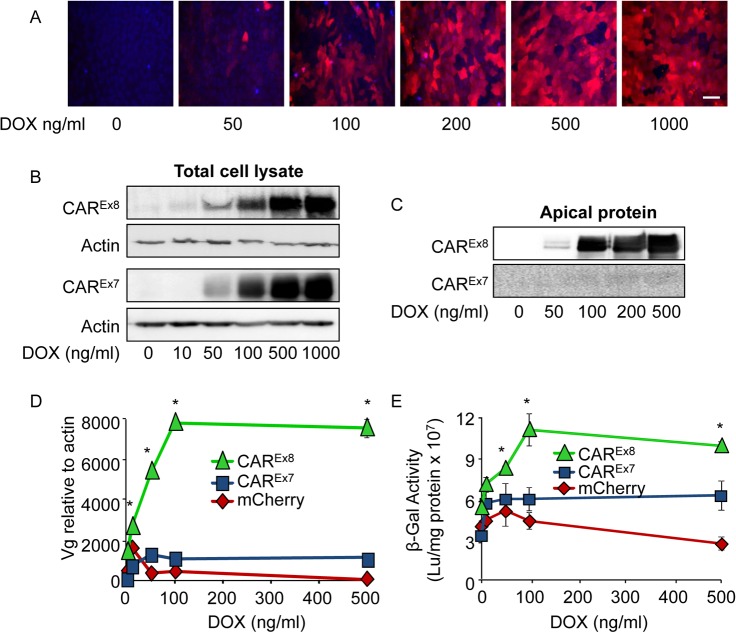
Induction of CAREx8 expression increases the susceptibility of polarized epithelia to AdV entry and transduction.A) MDCK-mCherry cells either mock (0) or DOX treated for 24 h were imaged using fluorescence microscopy (20X, white bar = 30 μm). Hoechst 33342 staining (blue) indicates cellular nuclei. B) Flag-CAREx8, Flag-CAREx7 protein expression was analyzed in lysates from MDCK-CAREx8 and-CAREx7 cells, respectively, after mock (0) or DOX induction. C) Apical surface-specific biotinylation of mock- (0) or DOX-induced polarized-MDCK-CAREx8 or-CAREx7 cells analyzed by Western blot using an anti-FLAG-tag Ab. D) Polarized MDCK-stable cells were treated with increasing concentrations of DOX for 24 h, transduced with AdV5-βGal from the apical surface for 1 h, and analyzed 24 h post-infection for viral entry by qPCR (viral genomes, Vg) or E) viral transduction via β-gal activity. Error bars represent the SEM from three independent experiments; *p < 0.05 by two-way ANOVA.